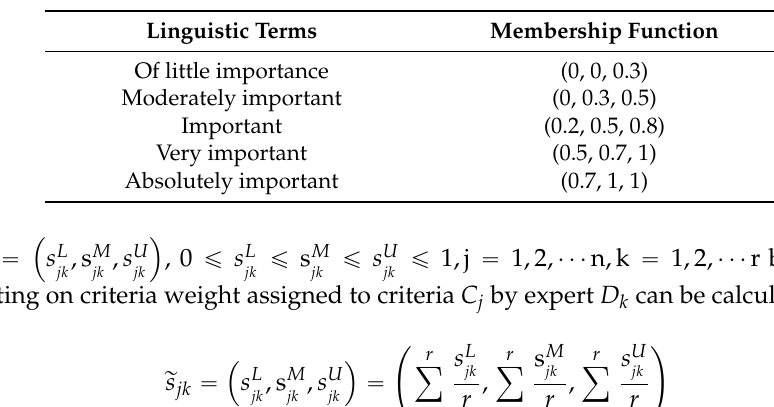
Table 2. Fuzzy evaluation scores for criteria